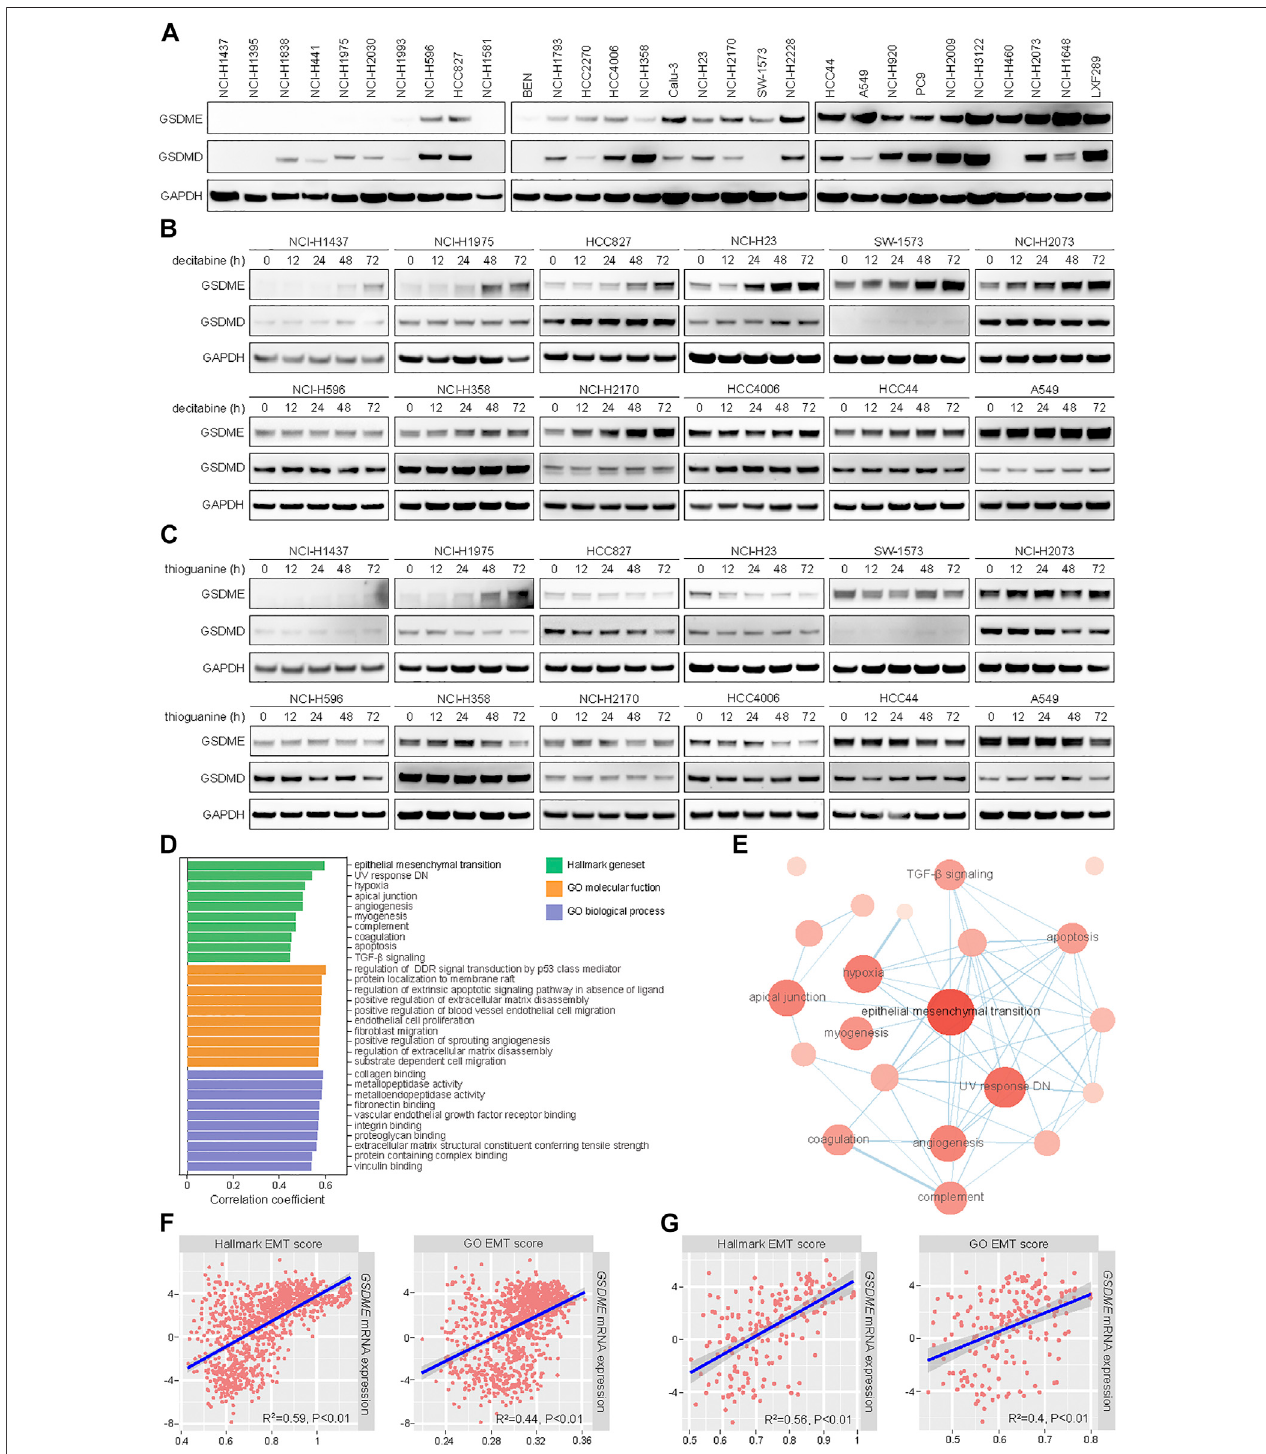
FIGURE1| Positivecorrelationofexpressionlevelsbetween GSDME geneandEMTmarkersinhumancancer. (A) TheproteinexpressionofGSDMEandGSDMD was analyzed by Western blot in 30 lung cancer cell lines. (B) Indicated lung cancer cell lines with variable GSDME levels were treated with decitabine (4 μ M) at a time course manner and analyzed by Western blot for GSDME and GSDMD protein expression. (C) Indicated lung cancer cell lines with variable GSDME levels were treated with thioguanine (4 μ M) at a time course manner and analyzed by Western blot for GSDME and GSDMD protein expression. (D) Hallmark gene sets and gene ontology terms with ssGSEA scores that positively correlated with GSDME transcript expression in CCLE cancer cell lines. (E) The interaction network of hallmark gene